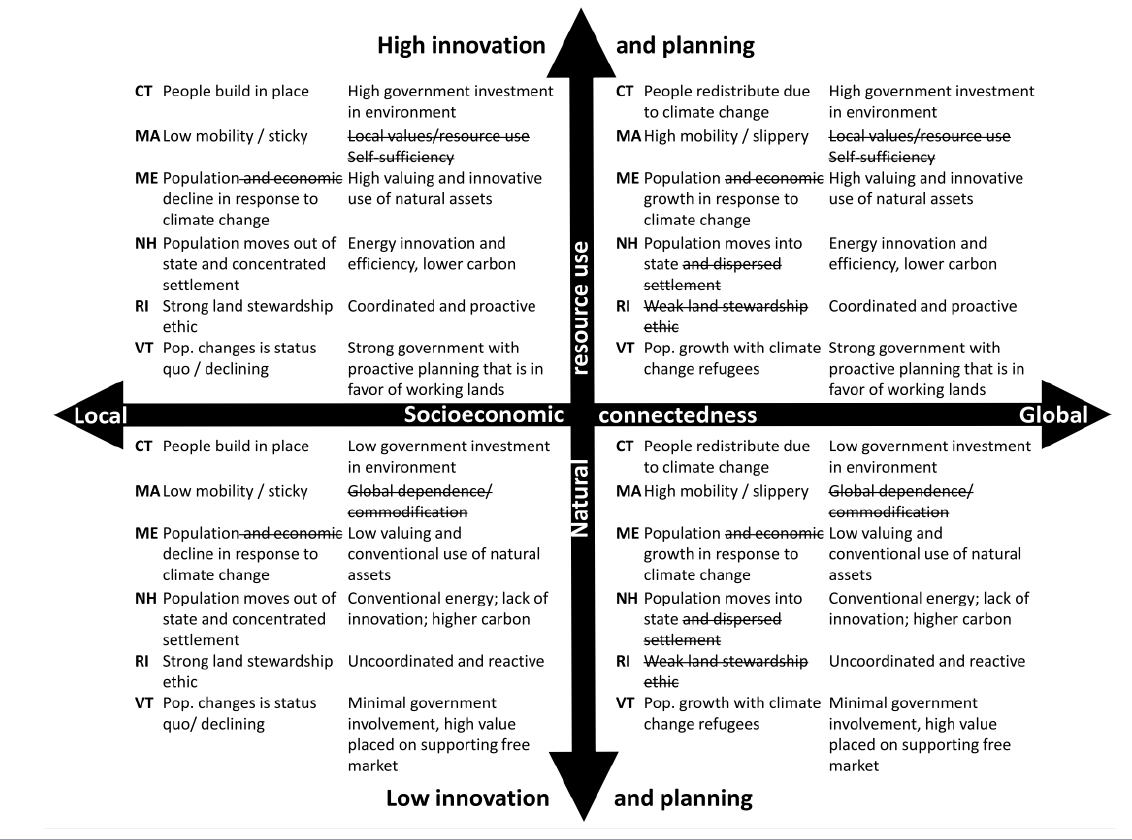
Fig. 3 . Illustration of step (1) in the regionalization process, the merging of individual state matrices into a regional, overarching matrix. Crossed out text indicates those elements of the state matrices that were removed in resolving the individual state matrices into a coherent regional